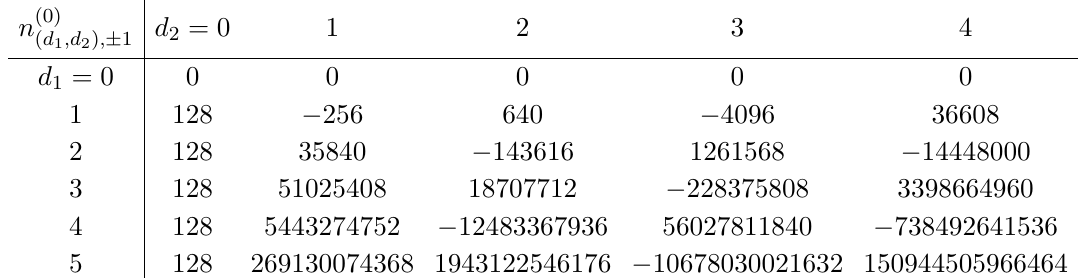
with Z charge ± 1 . 4 0